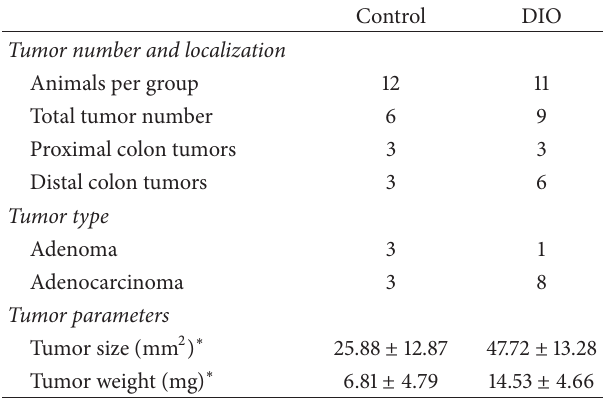
Table 3: Characterization of colon tumors in normal weight (con- trol) or diet-induced obese (DIO) rats treated with azoxymethane (AOM).